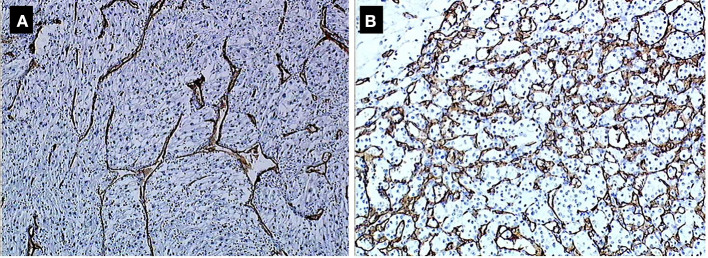
(A) Type 2 (low density). (B) Type 1 (high density) vascular stoma.